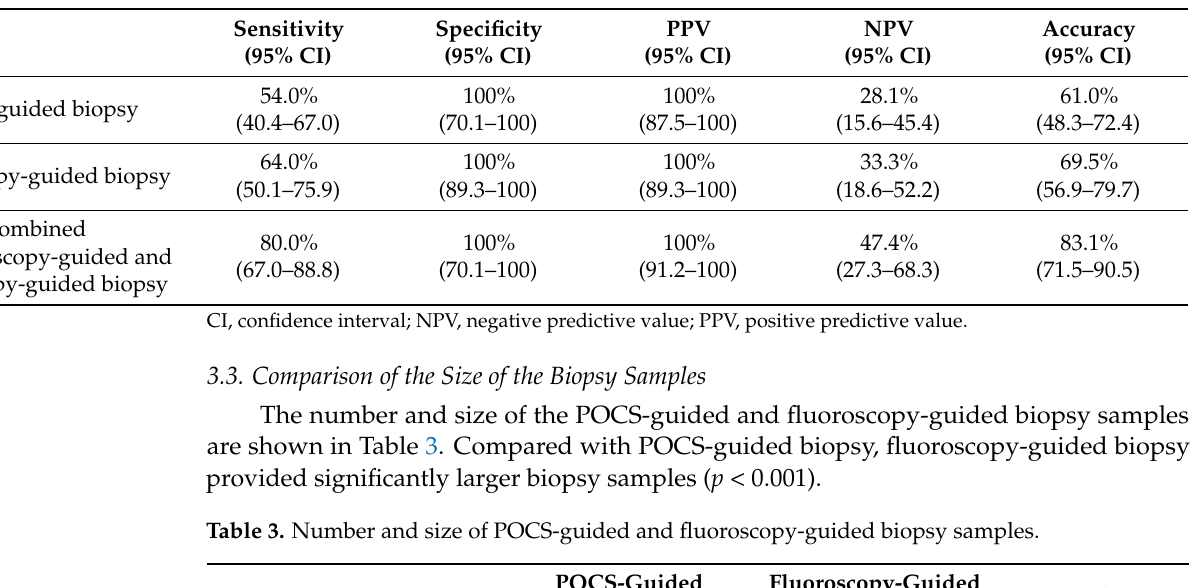
Table 2. Comparison of diagnostic results for suspected biliary duct cancer between POCS-guided and fluoroscopy-guided biopsy (n = 59).